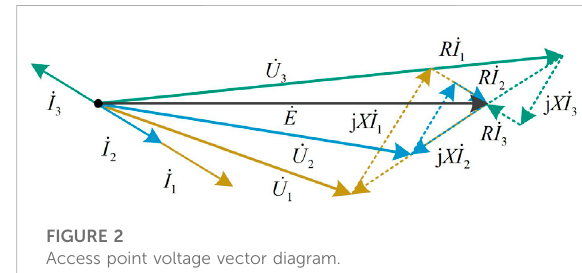
FIGURE 2 Access point voltage vector